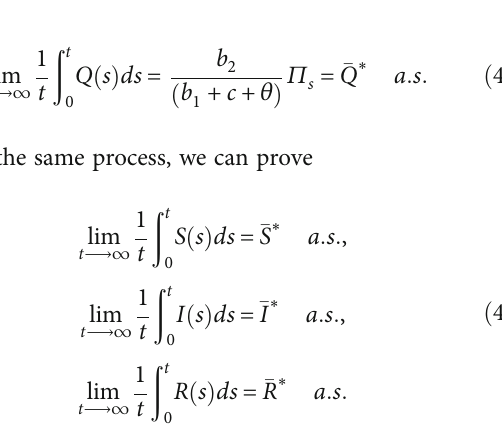
= 0 : 6 , σ = 0 : 7 , σ = 0 : 6 , σ 1 2 3